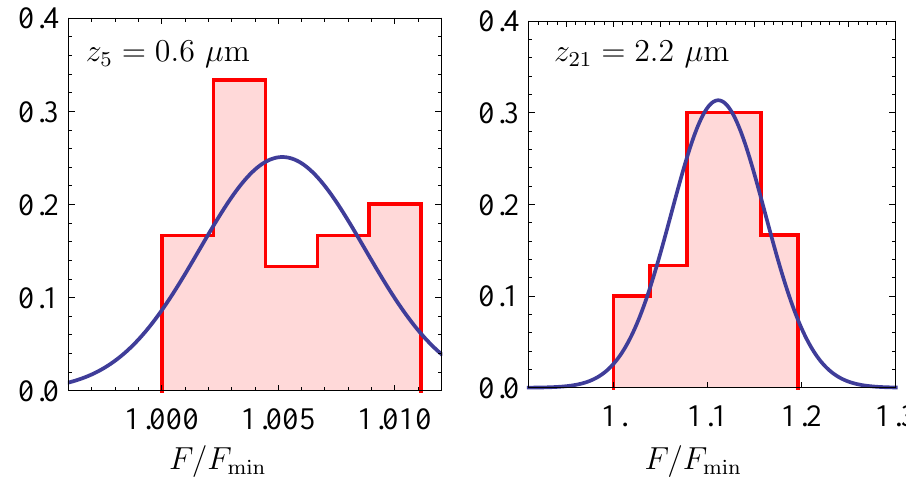
Figure 11. The histograms at z 5 = 0.6 µ m ( left ) and z 21 = 2.2 µ m ( right